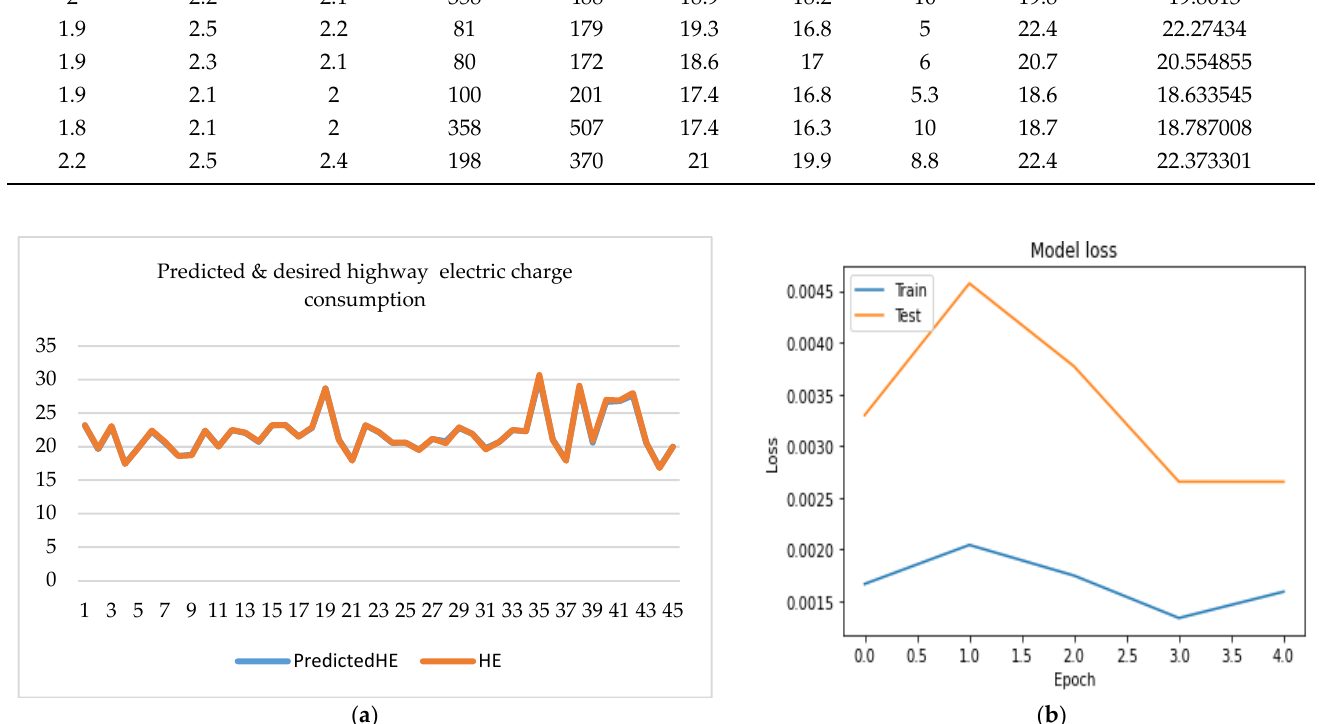
Figure 9. Predicted highway electric charge consumption analysis. ( a ) Behaviour of the highway electric charge consumption; ( b ) Model loss with increase in epoch. Table 5. Predicted and desired highway electric charge consumption.